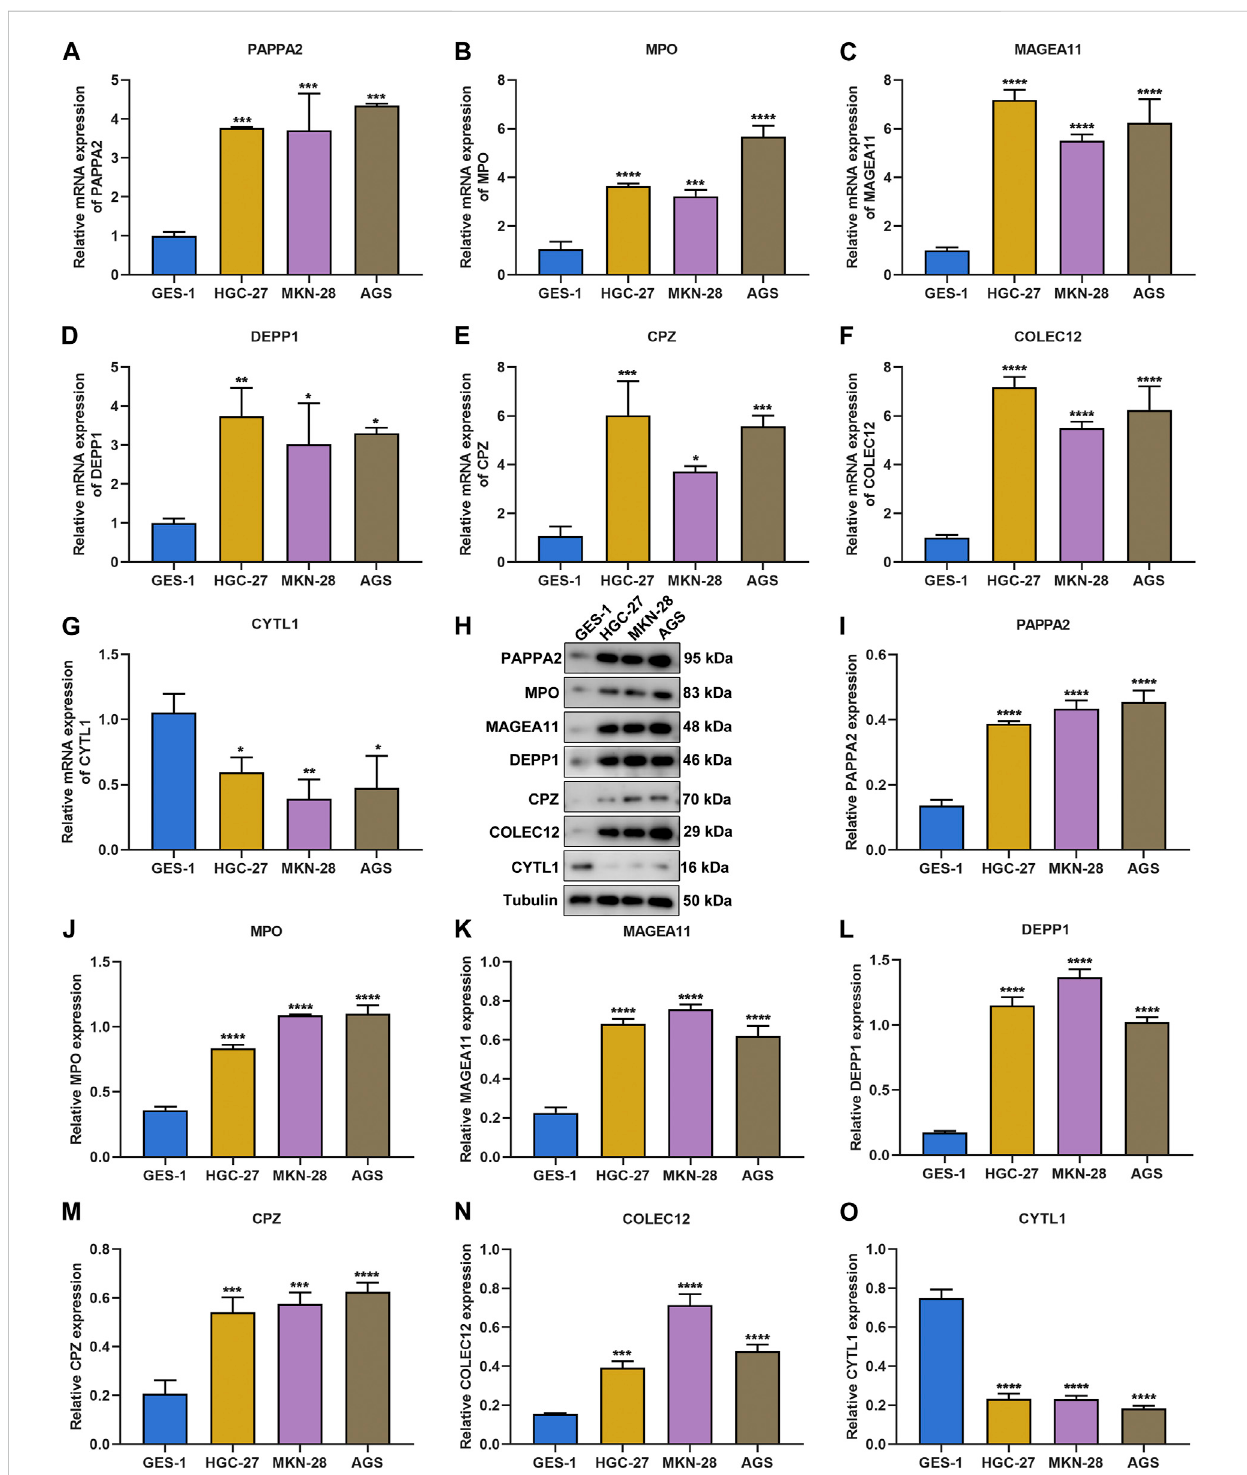
FIGURE 9 Experimentalveri fi cationoftheDNAdamagerepair-relevantgenes. (A – G) RT-qPCRofthetranscriptionallevelsofPAPPA2,MPO,MAGEA11,DEPP1, CPZ, COLEC12, and CYTL1 in GES-1, HGC-27, MKN-28 and AGS cell lines. (H – O) Immunoblotting of the protein levels of PAPPA2, MPO, MAGEA11, DEPP1, CPZ, COLEC12, and CYTL1 in GES-1, HGC-27, MKN-28, and AGS cell